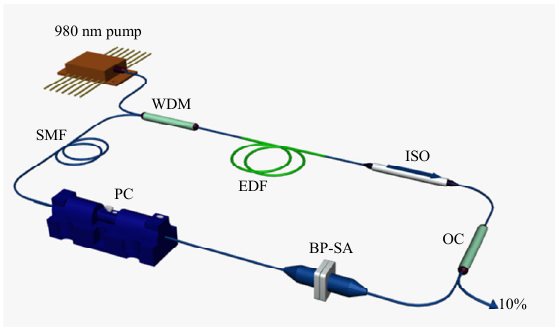
Fig. 3 Experimental setup of an erbium-doped Q-switched fiber laser based on BP-SA. WDM: wavelength division multiplexing; EDF: erbium-doped fiber; ISO: isolator; OC: output coupler; BP-SA: black-phosphorus-based saturable absorber; PC: polarization controller; SMF: single mode fiber.